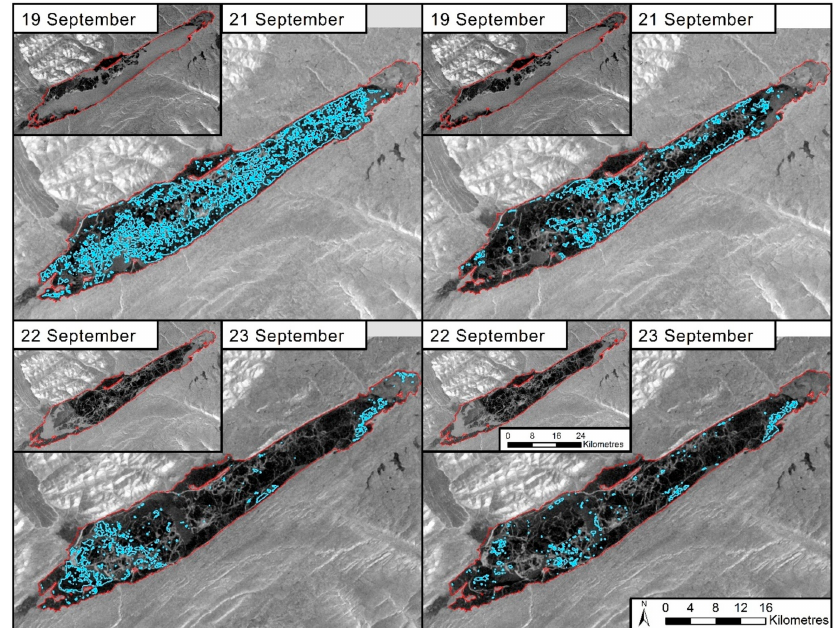
Figure 17. Representation of ice formation during freeze-up using the first di ff erence method (left column) and Otsu method (right column) in 2016. The light blue polygons highlight the areas where ice-on was captured on each respective date. This figure contains Copernicus Sentinel-1 data (2016), processed by